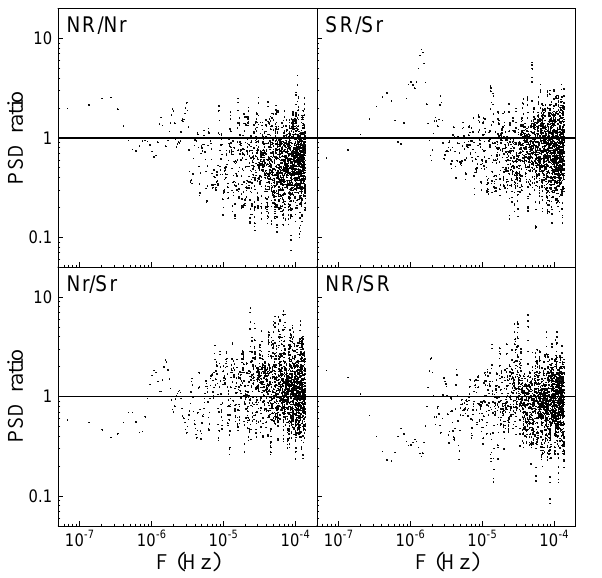
Fig. 3. Power density ratios are plotted to compare results in the analysed intervals. The upper panels refer to radial variations in the same hemisphere, while a comparison between the two hemi- spheres, for approximately the same radial range, is performed in the lower panels.